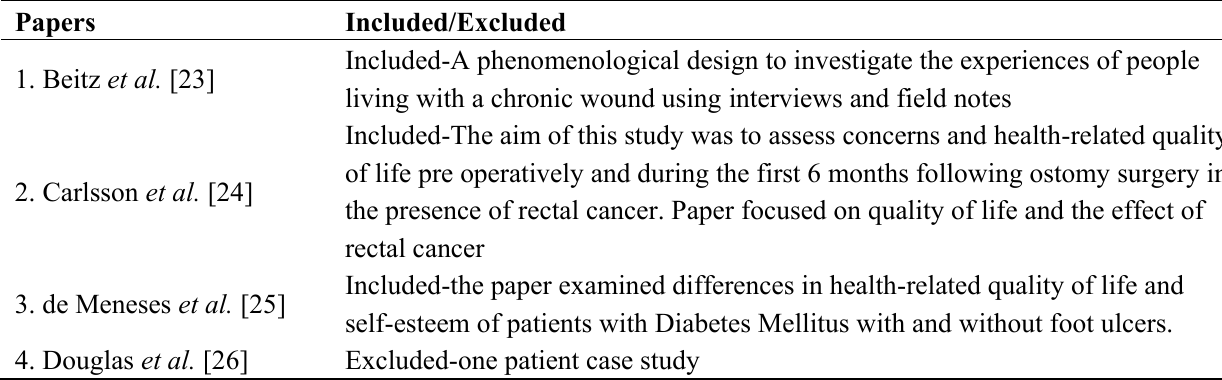
Table 1. Papers reviewed and included or excluded with